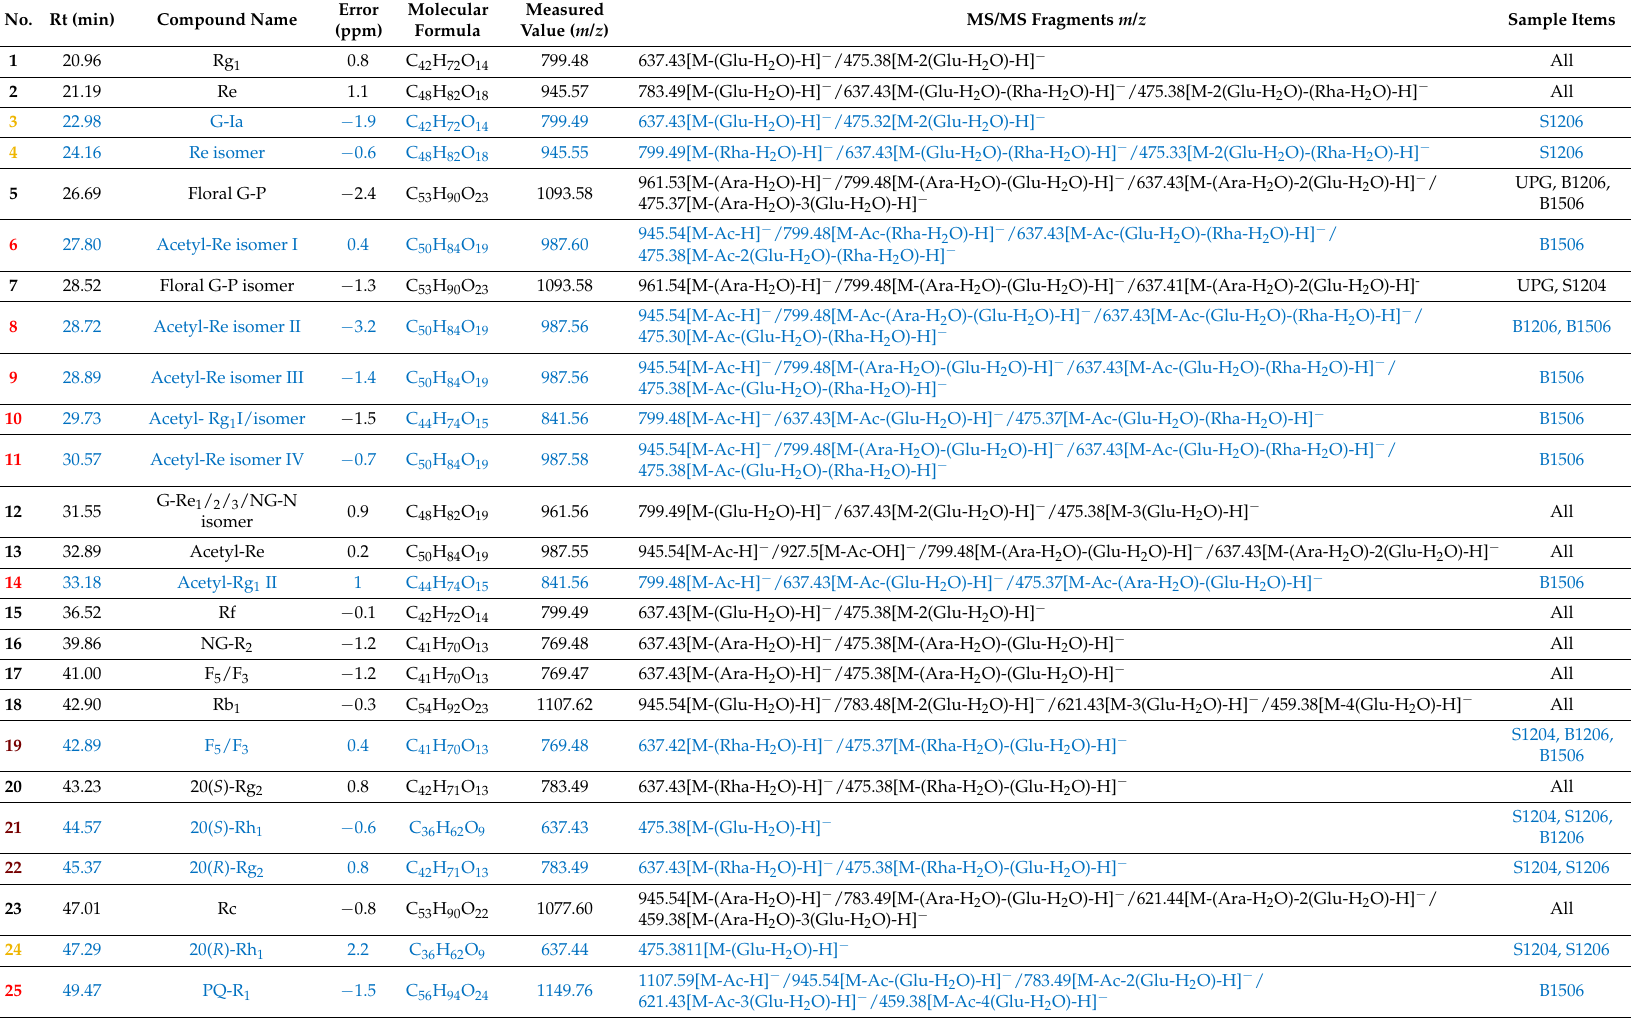
Table 1. Identification of ginsenosides by UPLC-Q-TOF/MS in ginseng flowers before and after baking and steaming